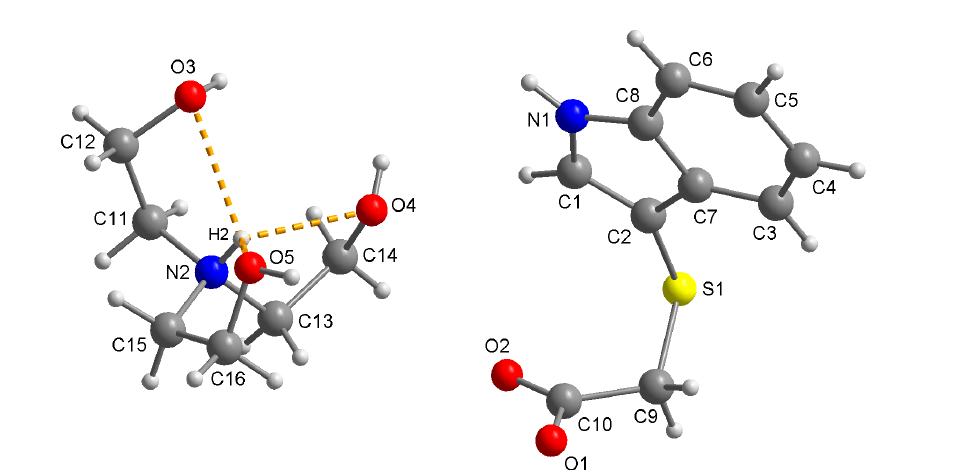
Fig. 2. Selected bond lengths (Å), bond angles (°) as well